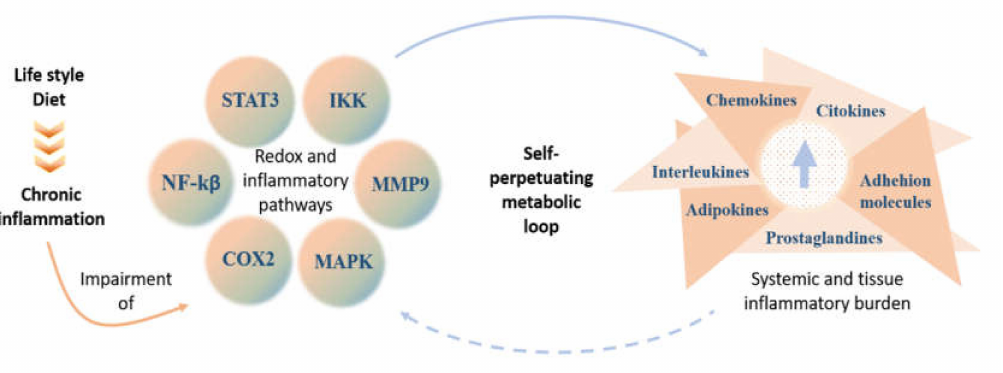
Figure 1. Impairment of metabolic pathways in lifestyle-associated low-grade chronic inflammation. STAT3 (signal transducer and activator of transcription 3), IKK (I κ B kinase), MMP9 (matrix metallopeptidase 9), MAPK (mitogen-activated protein kinases), COX2 (cyclooxigenase 2), and NF-K β (nuclear factor kappa-light-chain-enhancer of activated B